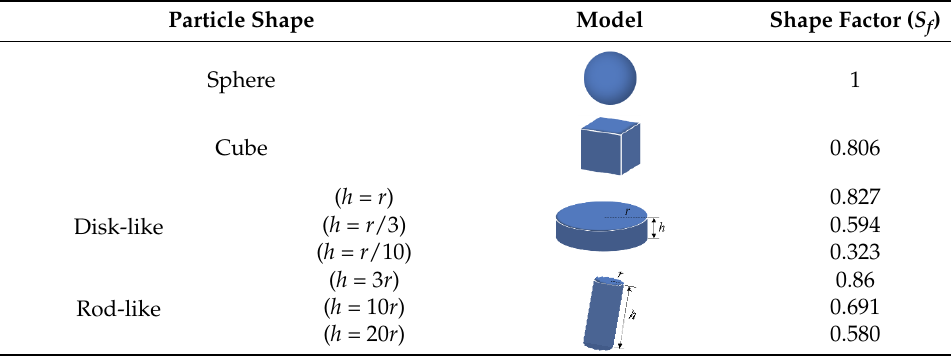
Table 2. The sphericity of several regular-shaped particles.